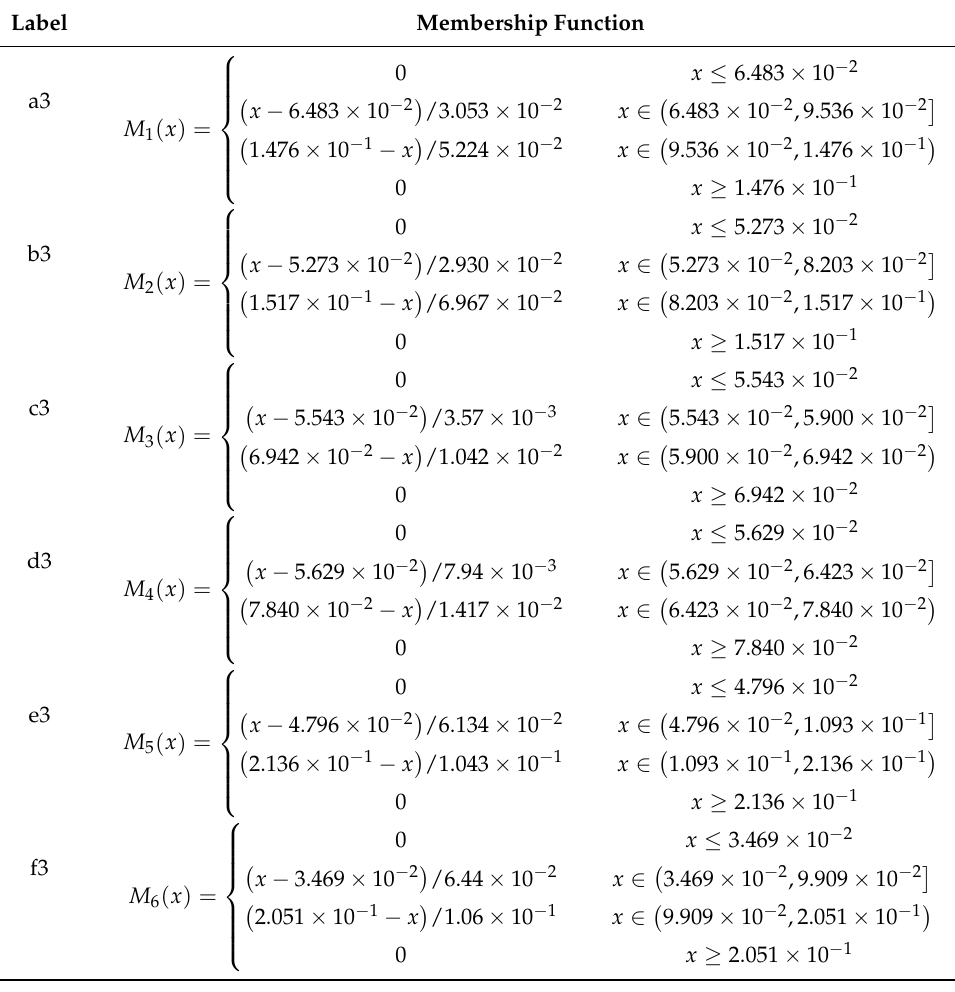
Tables 13 and 14 are the membership function and fuzzy set of the hydraulic motor. Table 13. Membership function of leakage fault in the hydraulic motor.